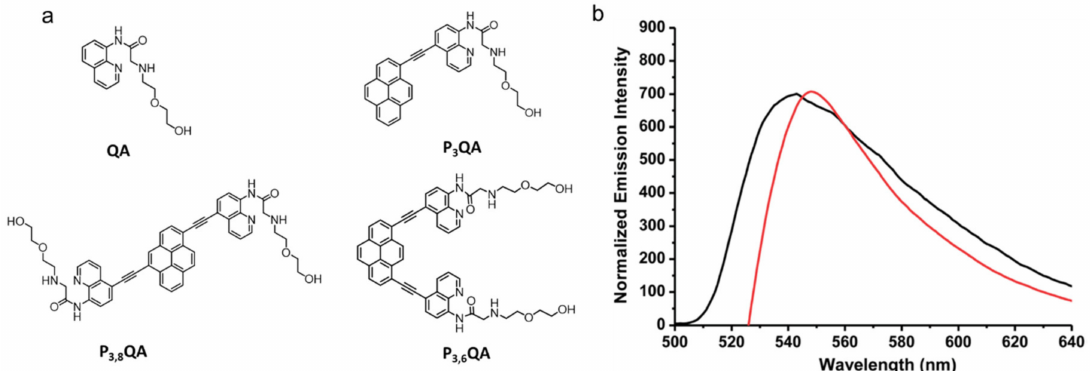
Figure 19. ( a ) Molecular structures of QA and ethynylpyrenyl derivatives of QA (P 3 QA, P 3,8 QA and P 3,6 QA). ( b ) Normalized fluorescence emission spectra of P 3,6 QA in the gel state (CGC concentration) in the absence of Zn 2+ (red curve) and in the presence of 0.5 equiv. of Zn 2+ (black curve) in acetone. Republished from [28] with permission of The Royal Society of